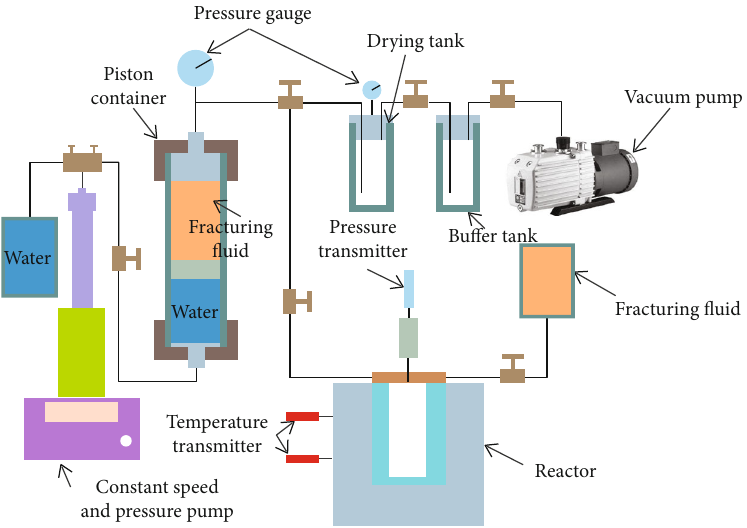
Figure 2: Schematic diagram of the experiment instrument